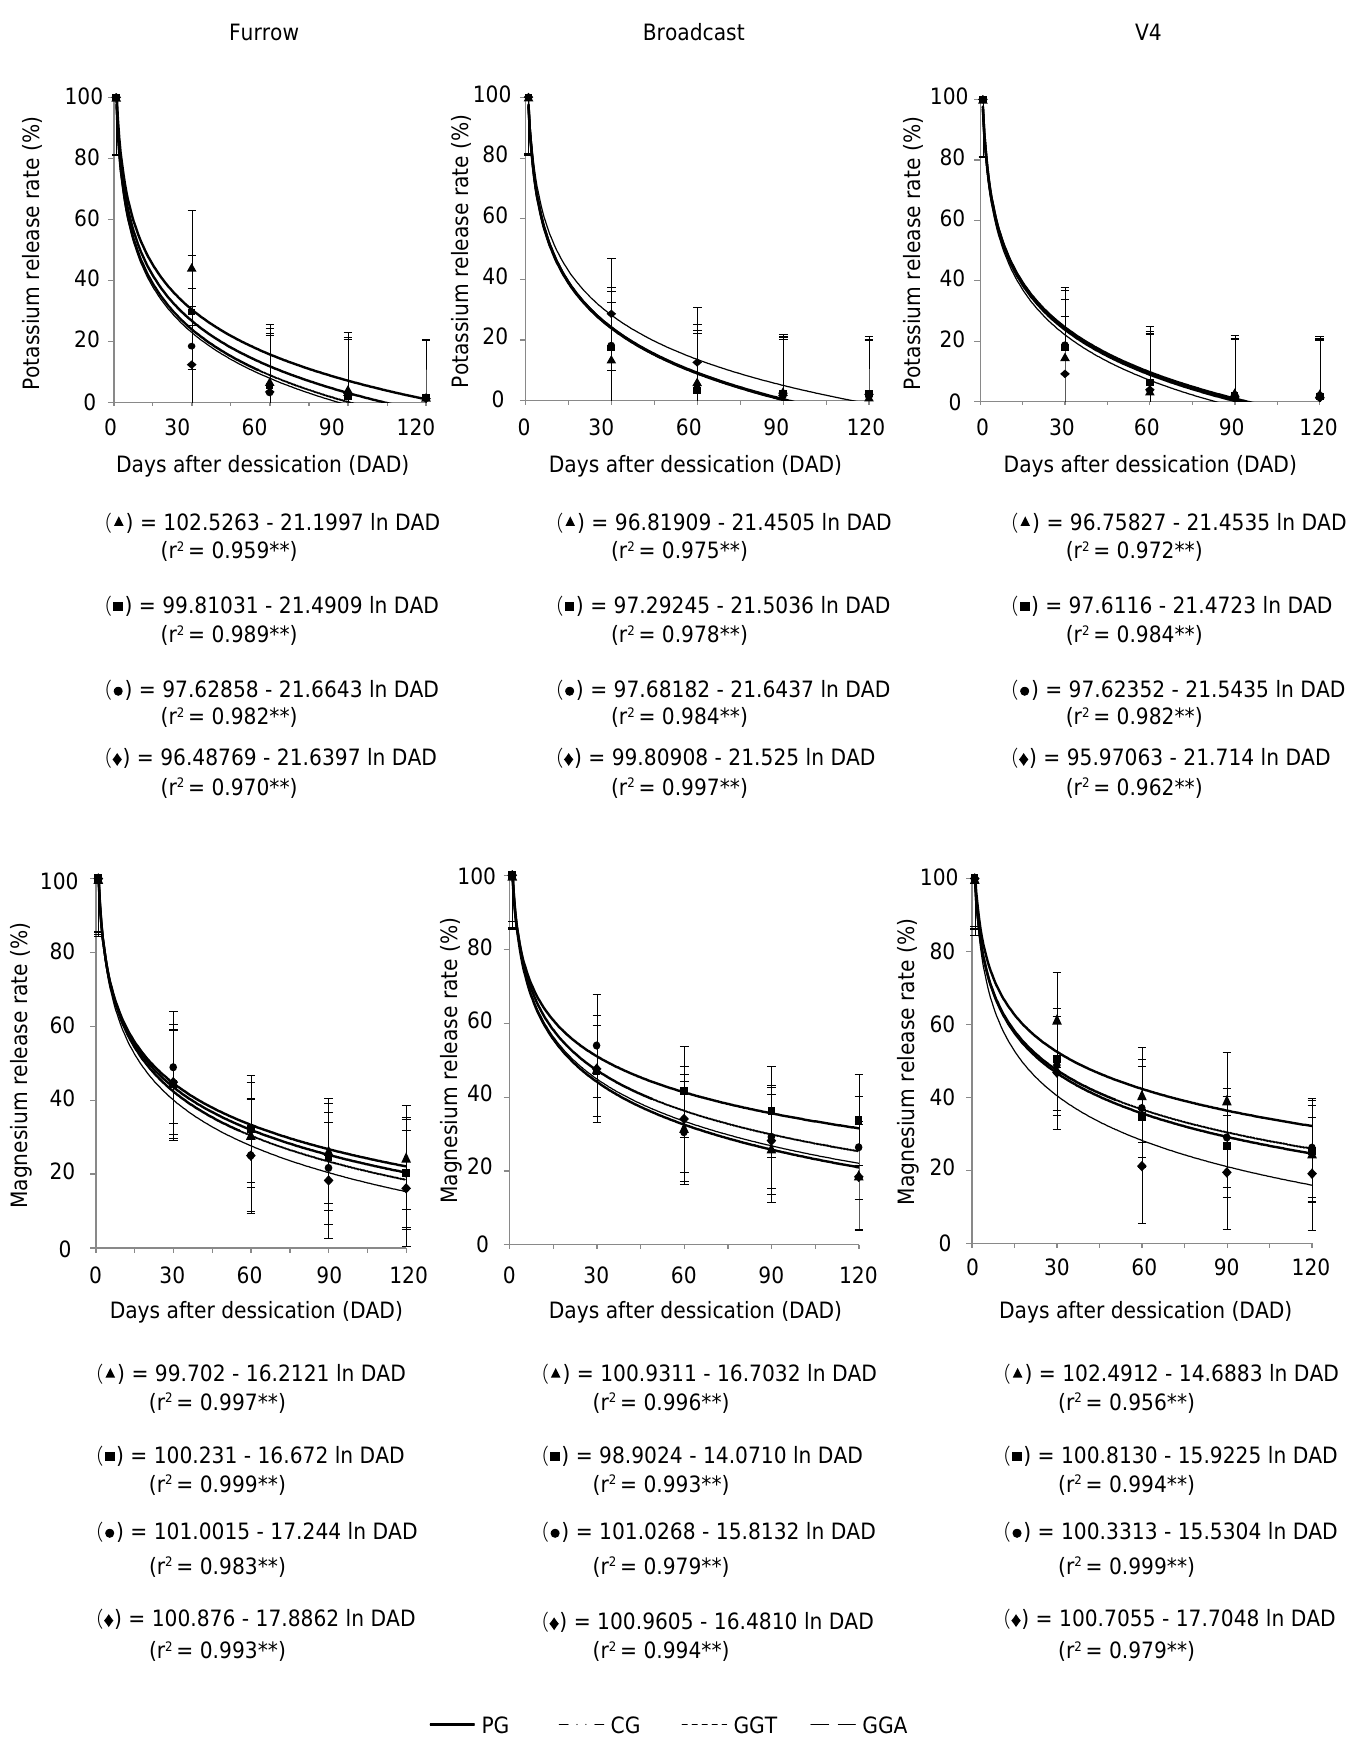
Figure 4. Potassium and magnesium release rate from forage straw after desiccation, in three methods of sowing forage-autumn maize intercrops. PG, CG, GGT and GGA: Palisade grass, Congo grass, Guinea grass cv. Tanzânia and Guinea grass cv. Áries, respectively. **: significant at 1